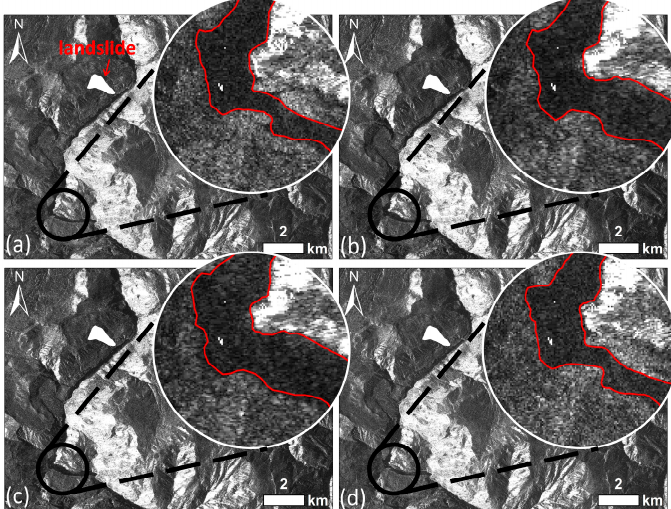
Figure 12. Different temporal SAR intensity images; the red lines present the waterline of the Jinsha river on the dates of ( a ) 9 January 2007; ( b ) 12 July 2007; ( c ) 20 July 2010; ( d ) 20 January 2011. Secondly, the backscattering coefficient of the SAR intensity image is used to inverse the soil moisture changes, as the increase in soil moisture results in an increase in radar backscattering [67]. In sparsely vegetated areas, the backscattering coefficient can be expressed as